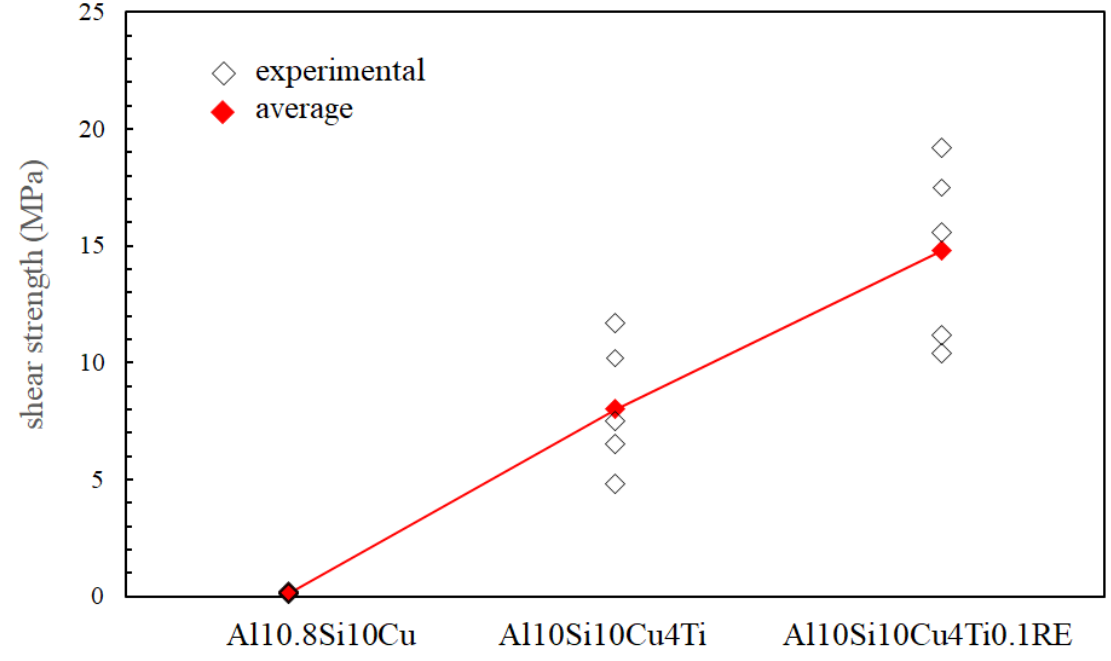
Figure 10. The shear strengths of AA6061/alumina joints bonded with Al10.8Si10Cu, Al10Si10Cu4Ti and Al10Si10Cu0.1RE filler alloys.